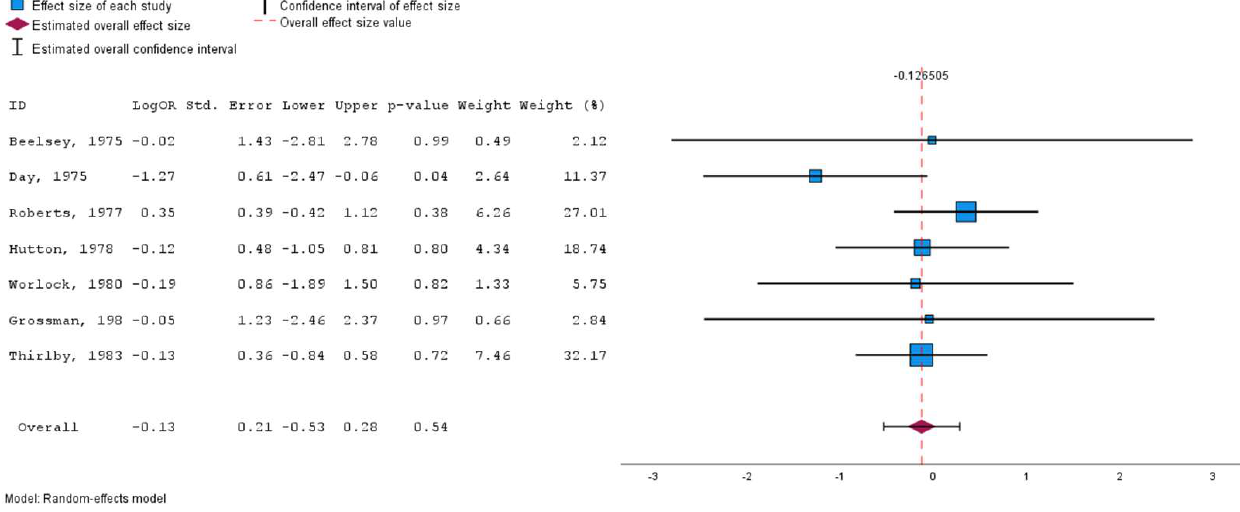
Figure 12. Forest Plot for Binary Data.